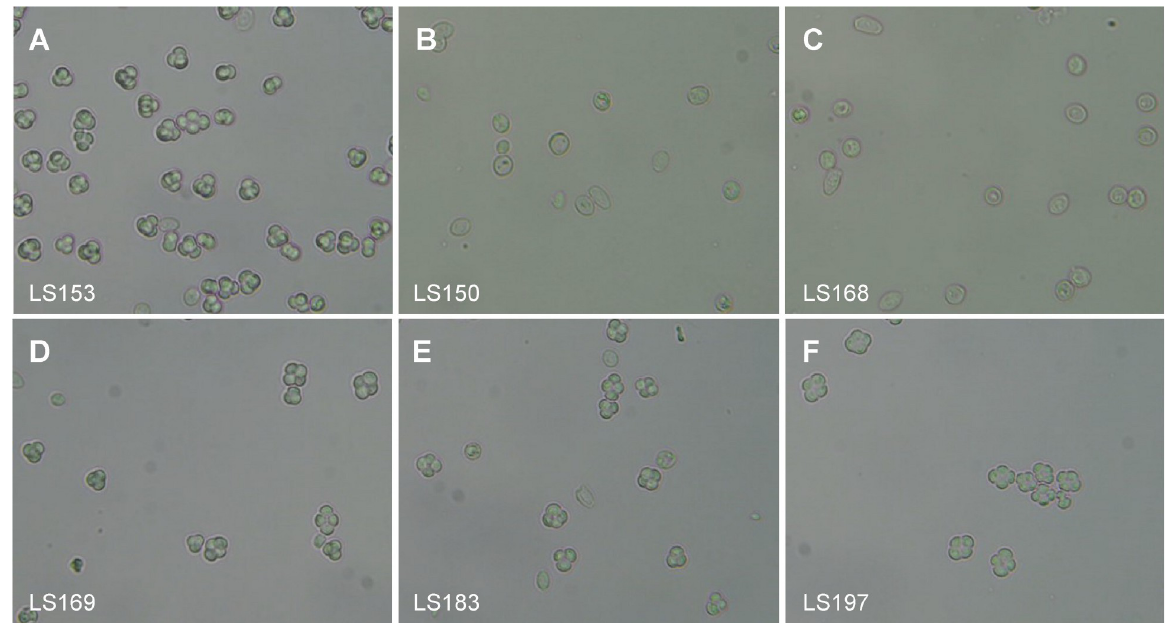
Fig 8. Sporulation phenotypes of S . cerevisiae diploid strains with and without Centroid genes. (A) Spores are formed in the control strain LS153. (B,C) Strains without the Centroid genes YNL018C and YNL034W do not form spores. No tetrads were seen in > 500 cells examined from each of LS150 and LS168. (D) Spores are formed in strain LS169 lacking the transmembrane protein genes YNL019C and YNL033W . (E,F) Spores are formed in strains in which both IRs were deleted and a Centroid gene ( YNL018C ) was reintroduced from either S . cerevisiae (LS183) or S . paradoxus